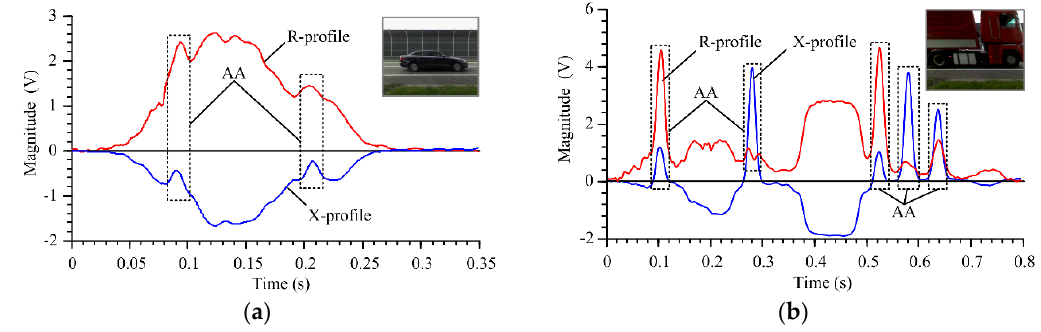
Figure 6. Examples of R- and X-profiles from narrow IL sensor: ( a ) passenger vehicle (low suspension); ( b ) truck vehicle (high suspension); where: AA—refers to the areas where there are artifacts originating from the vehicle axles.